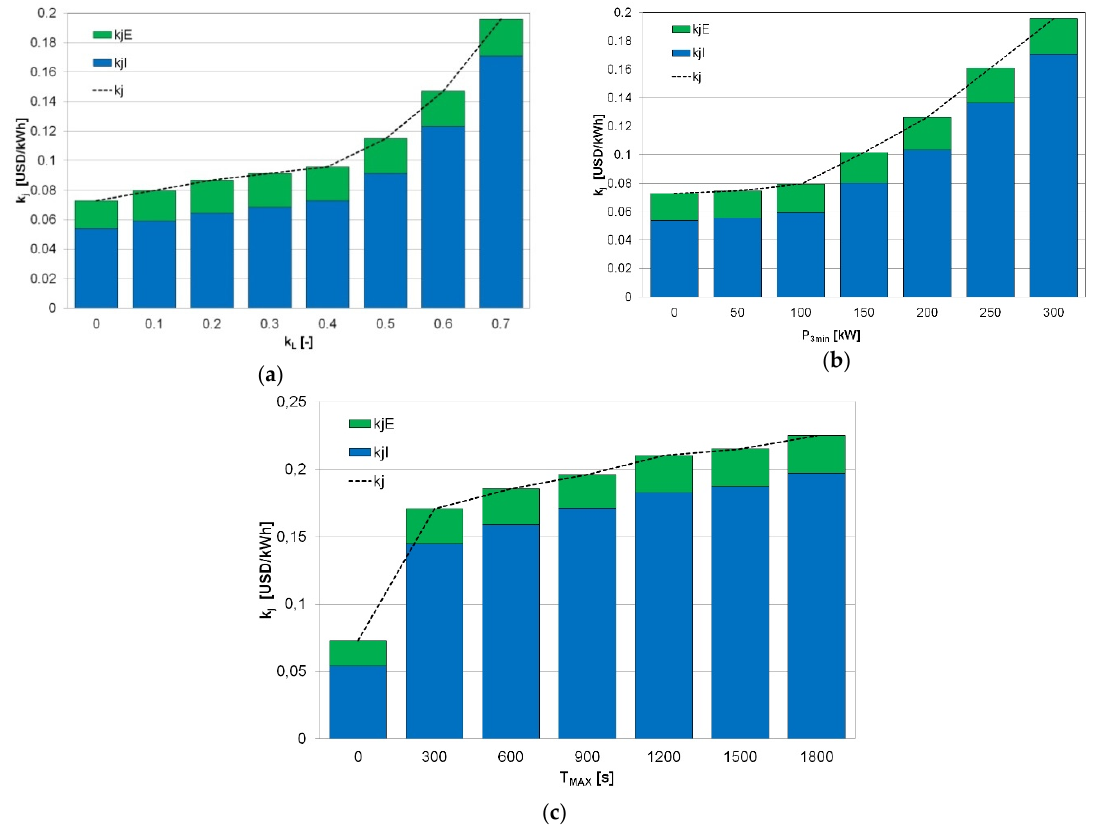
Figure 9. Values of the discounted unit cost of energy generation in the optimised WPP-FESS system for the year 2012 as a function of: ( a ) index of elimination of acceptable interruptions k L (P 3MIN = 300 kW, T MAX = 900 s); ( b ) P 3MIN power (T MAX = 600 s, k L = 0.7), ( c ) time TMAX (P 3MIN = 300 kW, k L = 0.7).